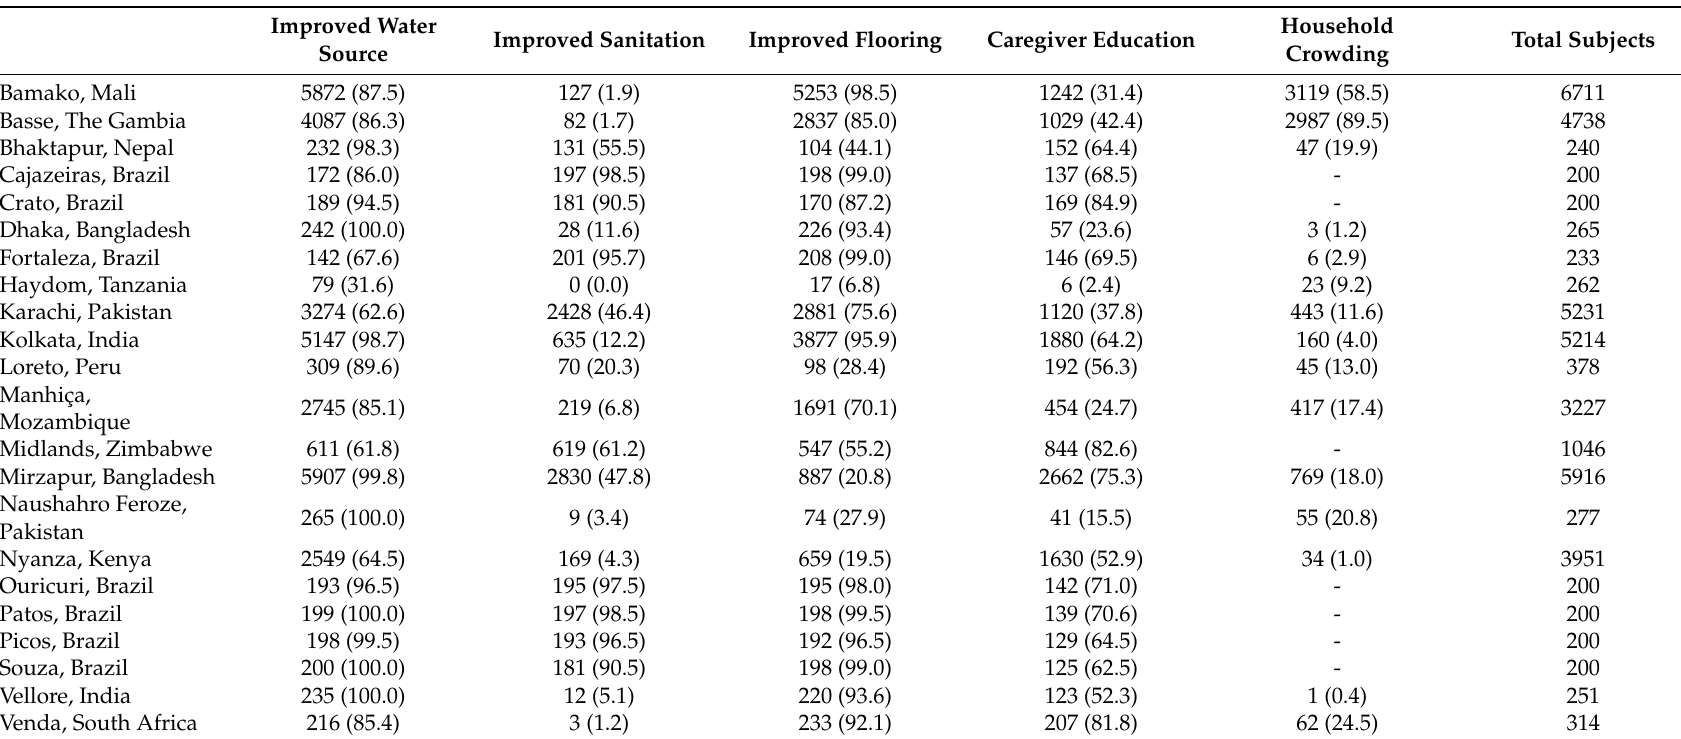
Table 2. Prevalence of 5 household-level exposures among study subjects aged 0–59 months in 22 study sites (before excluding samples not diagnosed with qPCR). Improved Water Improved Sanitation Improved Flooring Caregiver Education Source